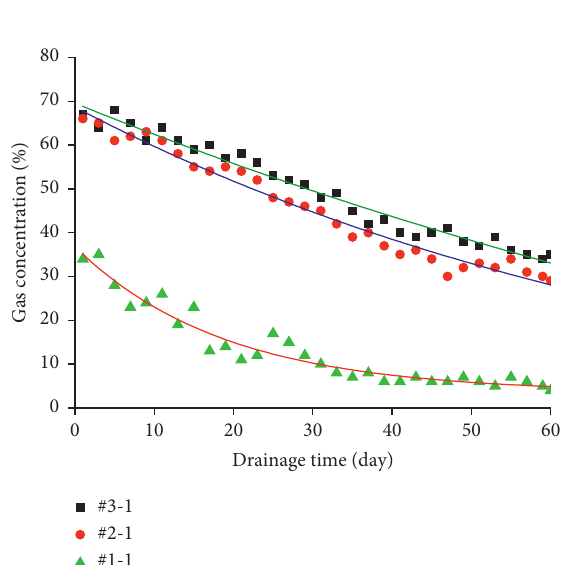
Figure 16: Curves of gas concentration in boreholes at monitor line 1.